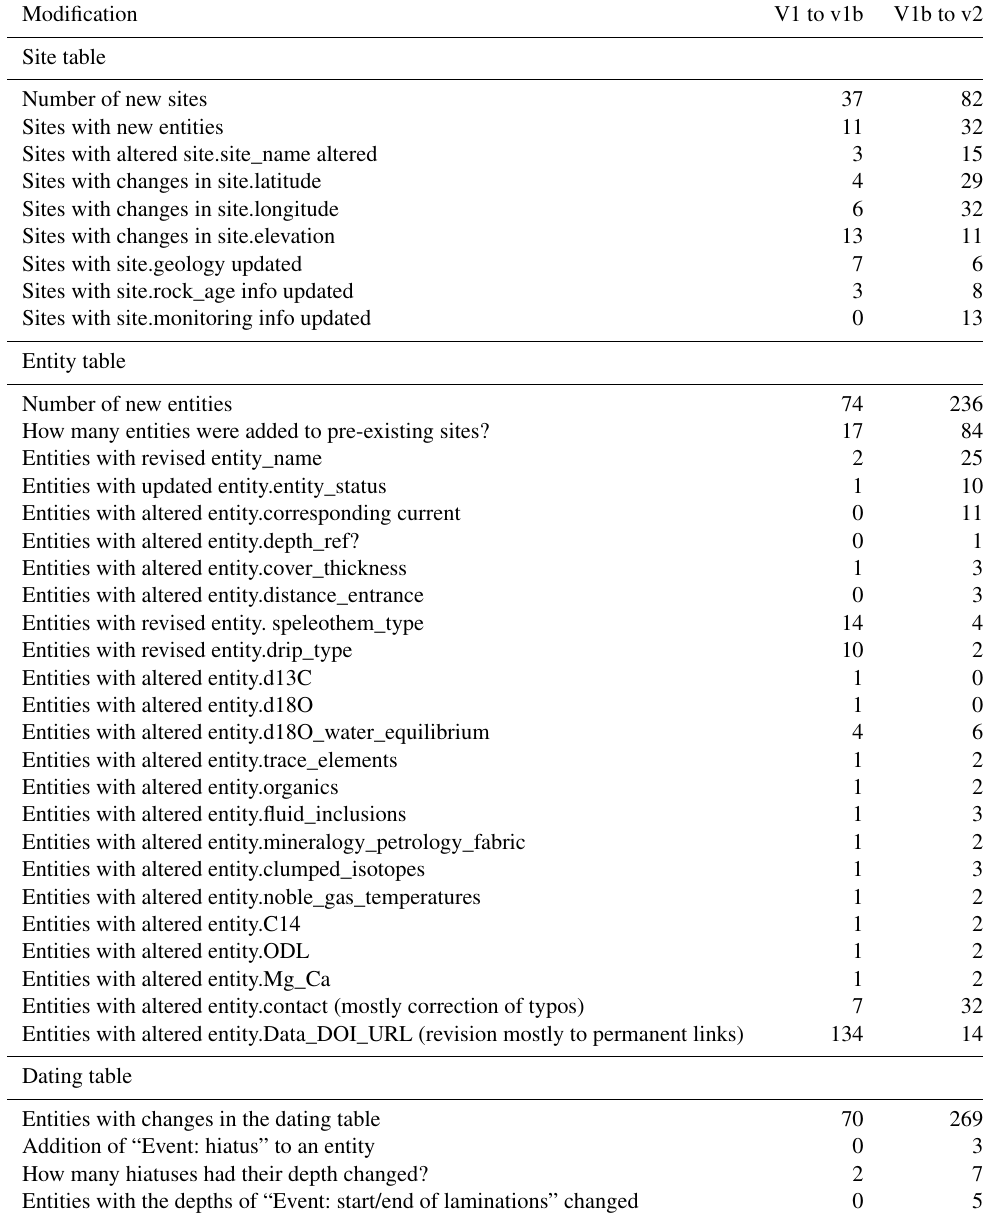
Table 4. Summary of the modifications applied to records already in version 1 (Atsawawaranunt et al., 2018b) and version 1b (Atsawawara- nunt et al., 2019) of the SISAL database. Mistakes in previous versions of the database were identified as outlined in the Supplement and through analysing the data for the SISAL